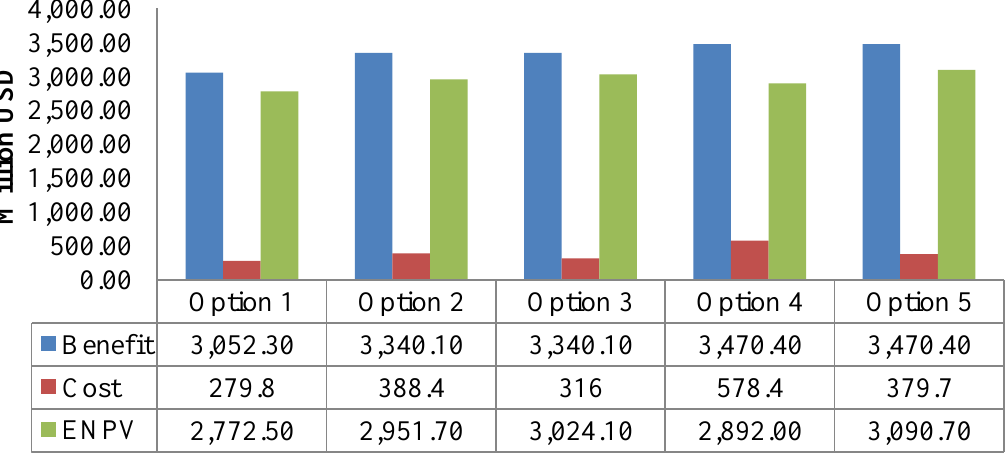
Figure 4. Cost-benefit analysis of sea dike options with uncertainty (discount rate =